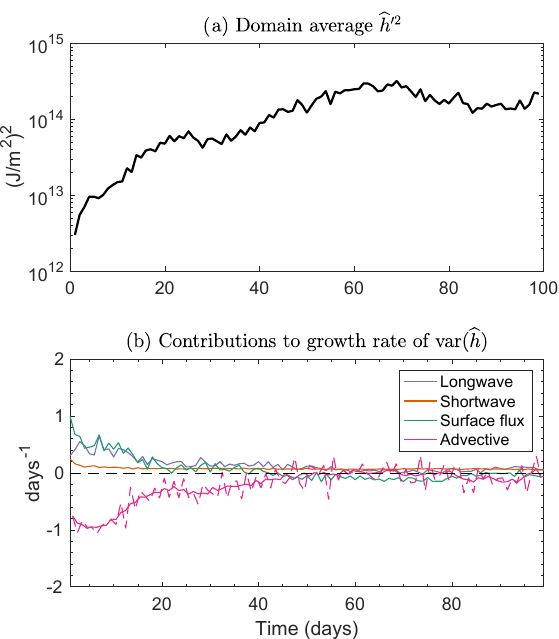
Figure 7. Domain average frozen moist static energy (FMSE) vari- ance (a) and terms in domain average FMSE variance budget, nor- malized by domain average FMSE variance (b) from the large- domain SAM simulation at T s =